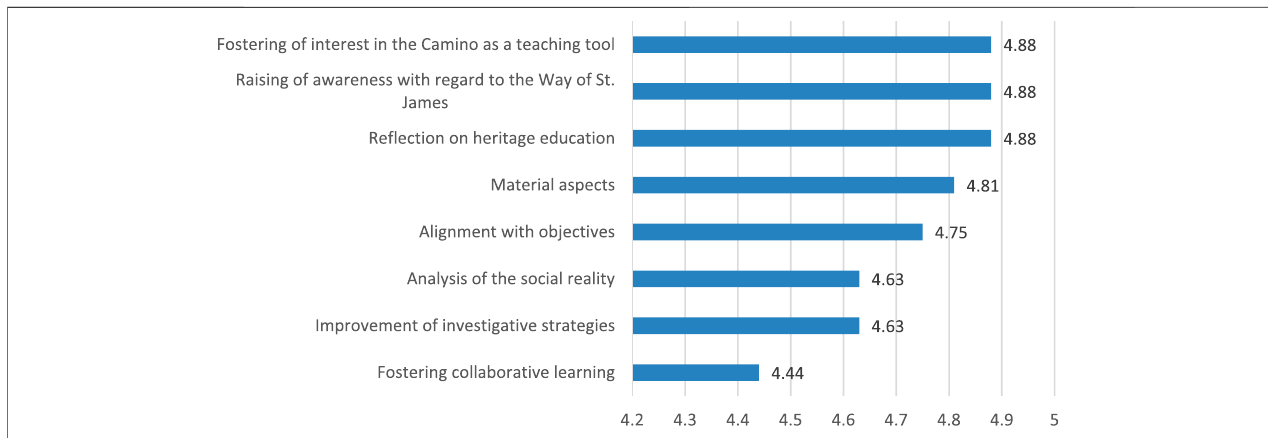
FIGURE 7 | Mean evaluation of the teaching experiment implemented on the Way of St. James.